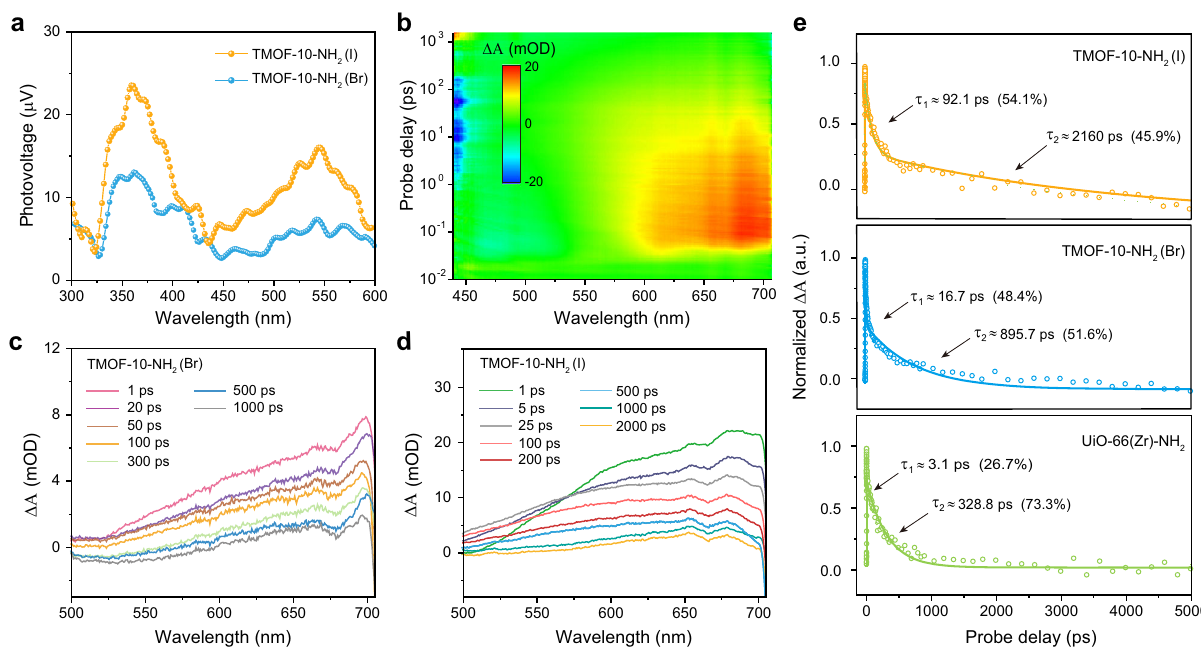
Fig. 4 | SPV and femtosecond ultrafast TA measurements of TMOF-10-NH 2 . a SPV spectra of TMOF-10-NH 2 (I) and TMOF-10-NH 2 (Br). b Two-dimensional pseudo-color TA plot of TMOF-10-NH 2 (I). c , d TA spectra of TMOF-10-NH 2 (Br) and